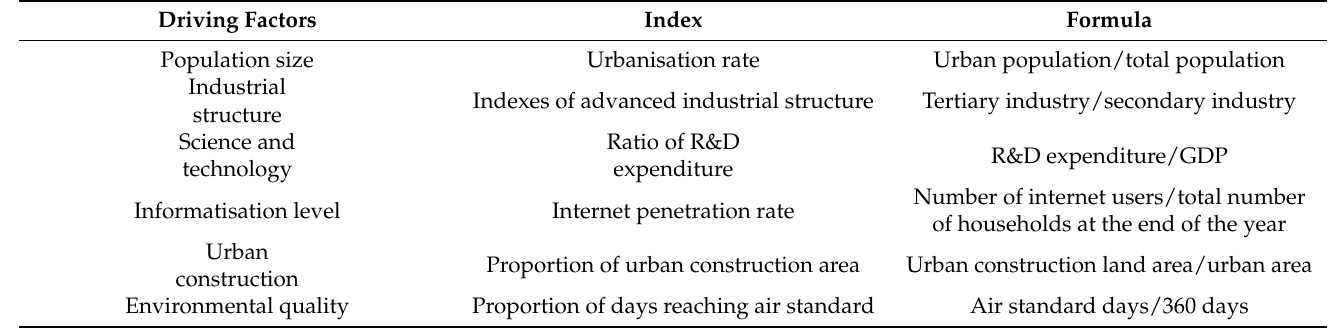
Table 3. Driving factors of HQD of seven urban